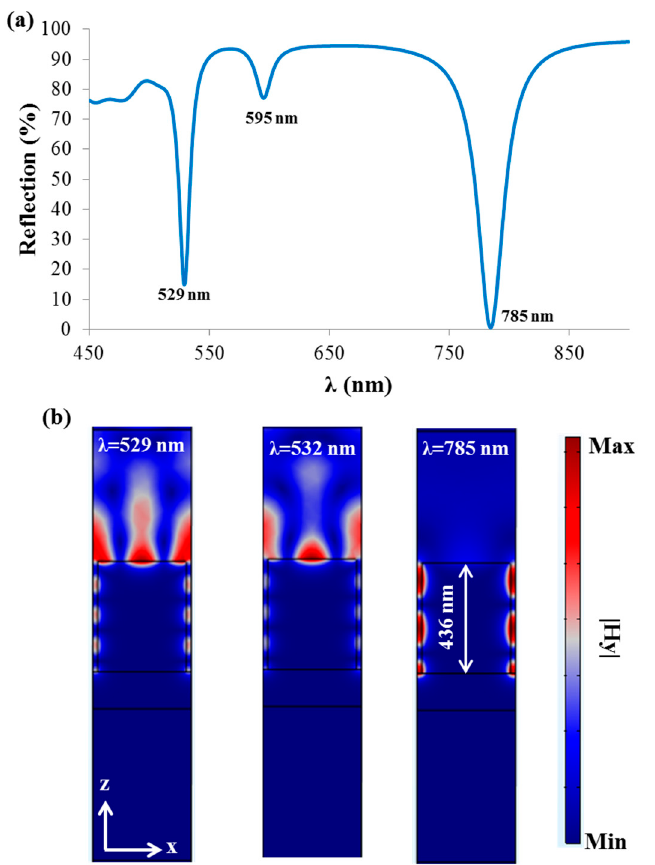
Figure 12. ( a ) Reflection spectra from the thick reflecting grating geometry (with Λ = 390 nm, h = 436 nm, and FF = 0.9) at 1.33 RI. ( b ) FD at the resonant wavelengths 529 nm and 785 nm as well as at 532 nm to simultaneously demonstrate the SEF and SERS enhancement. TM-polarized light under nor- mal incidence was used in the simulations of the Ag grating. Si was used for the substrate.